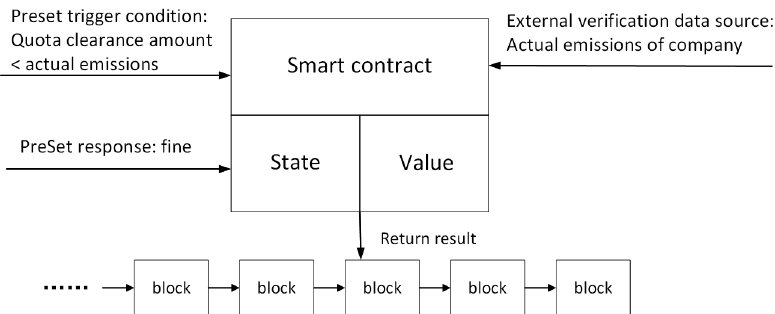
Figure 2. Execution mechanism of smart